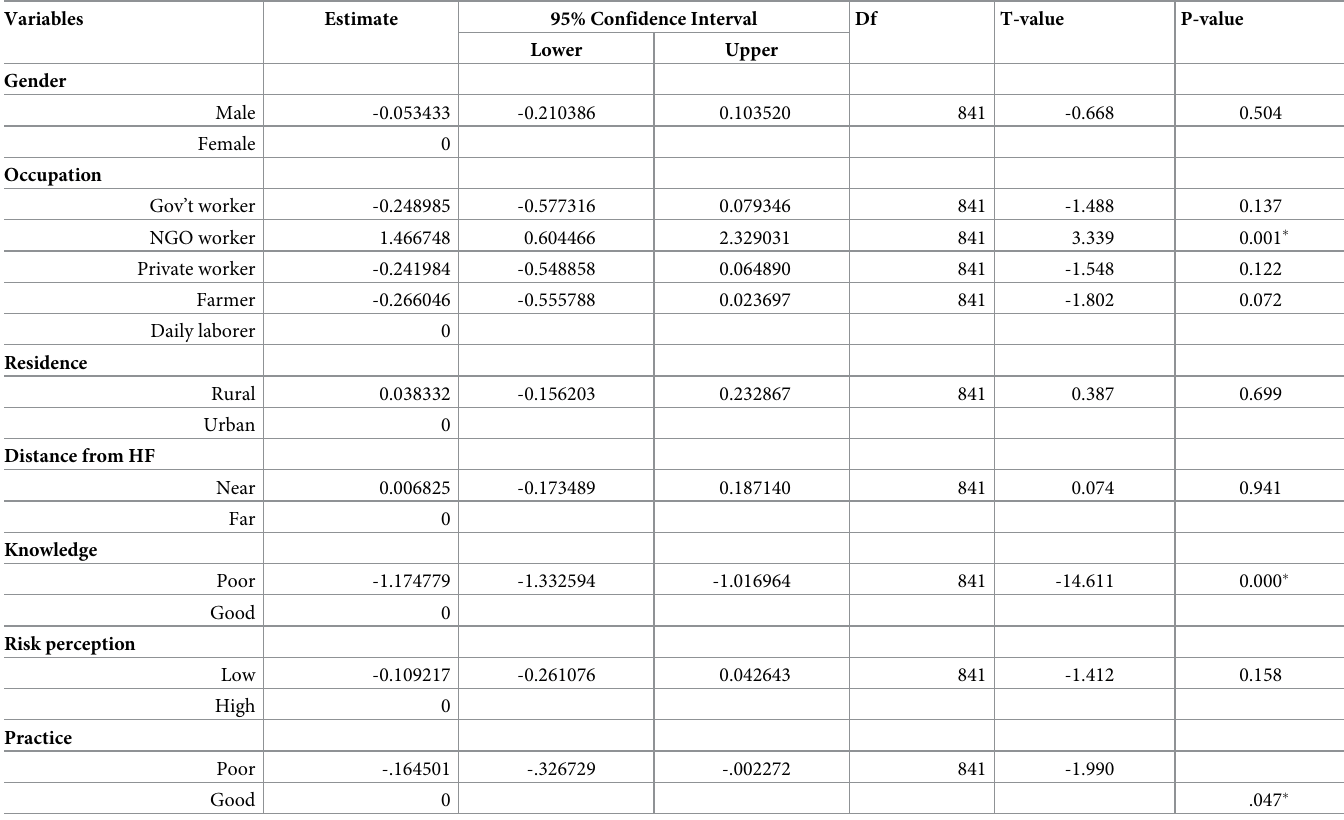
Table 4. Linear mixed model results of factors associated with community myth towards COVID-19 pandemic in East Bale and Bale Zone Southeast Ethiopia.